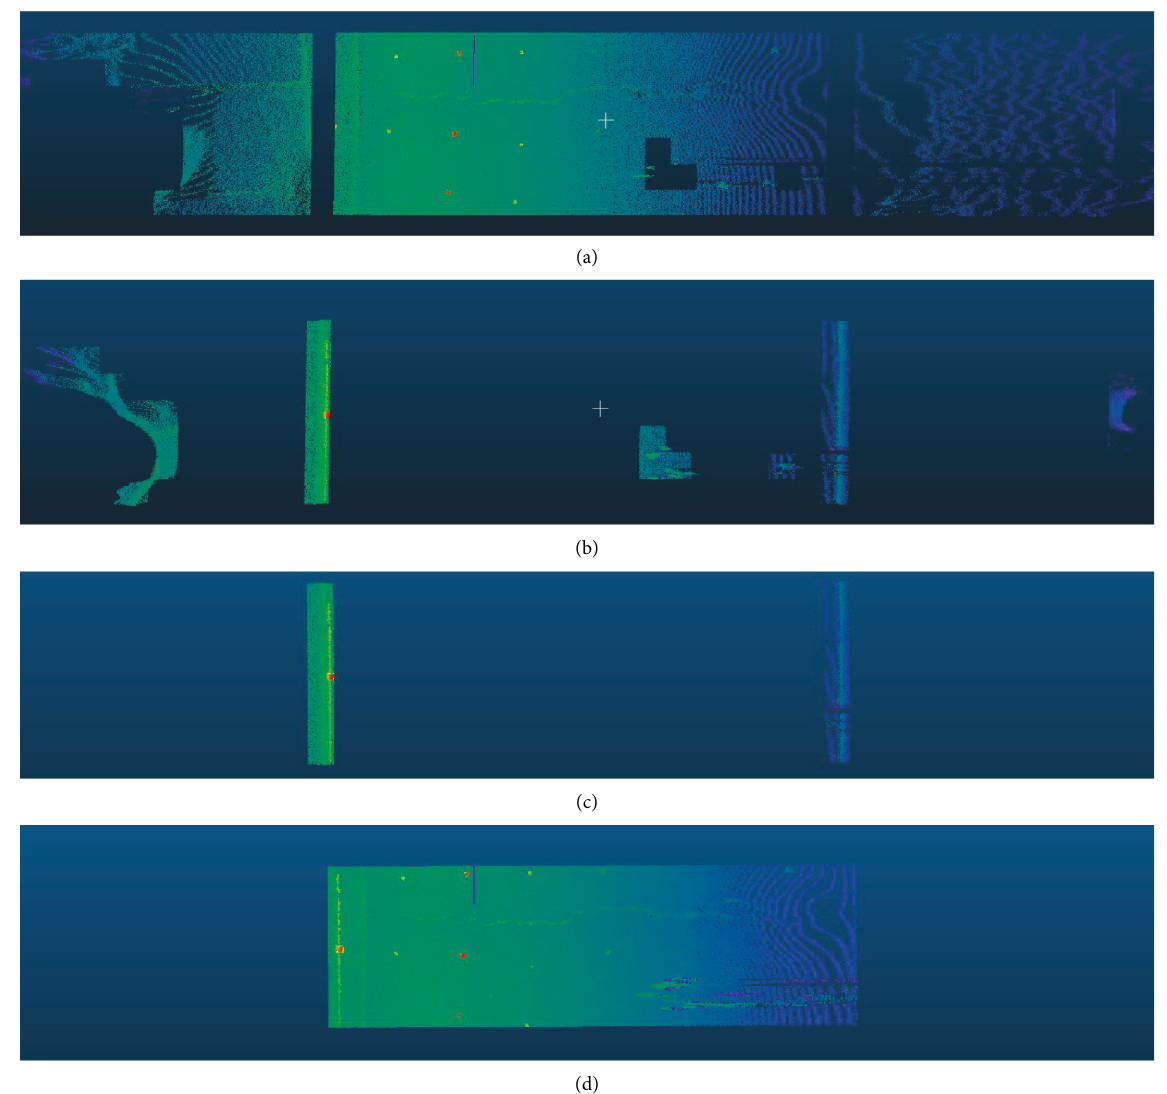
Figure 5: The results of classifying cells. (a) Flat cell, (b) noisy cells including curb cells and outlier cells, (c) curb cell, and (d) road